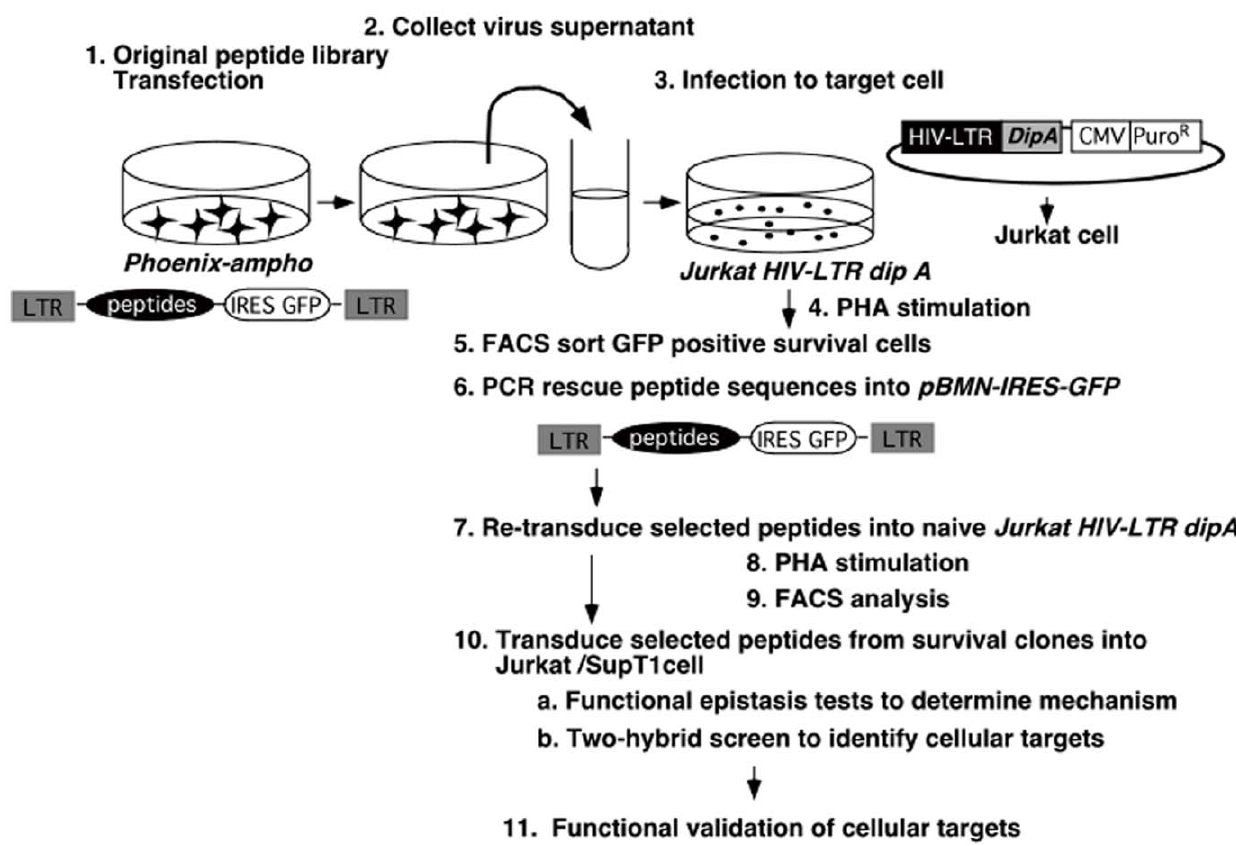
Figure 1. Overall strategy for screening using retrovirus peptide library. The retroviral peptide expression library is first transfected into the helper-free retroviral producer line by transient transfection. The supernatant containing the retrovirus-encoded peptide expression library is used to infect target Jurkat HIV-LTR dipA cells. The cells are subjected to PHA treatment, and GFP positive cells are selected and grown (GFP + cells should be peptide expressing and should enriched after selection). Genomic DNA is derived from the sorted cells. PCR amplified DNA, using primers flanking the peptide inserts, was cleaved with restriction endonucleases and recloned into new vectors for retesting.